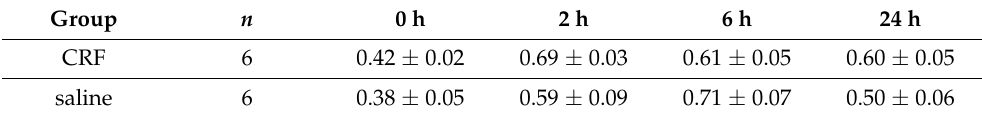
Table 1. The changes of serum corticosterone levels in each time points in rats.